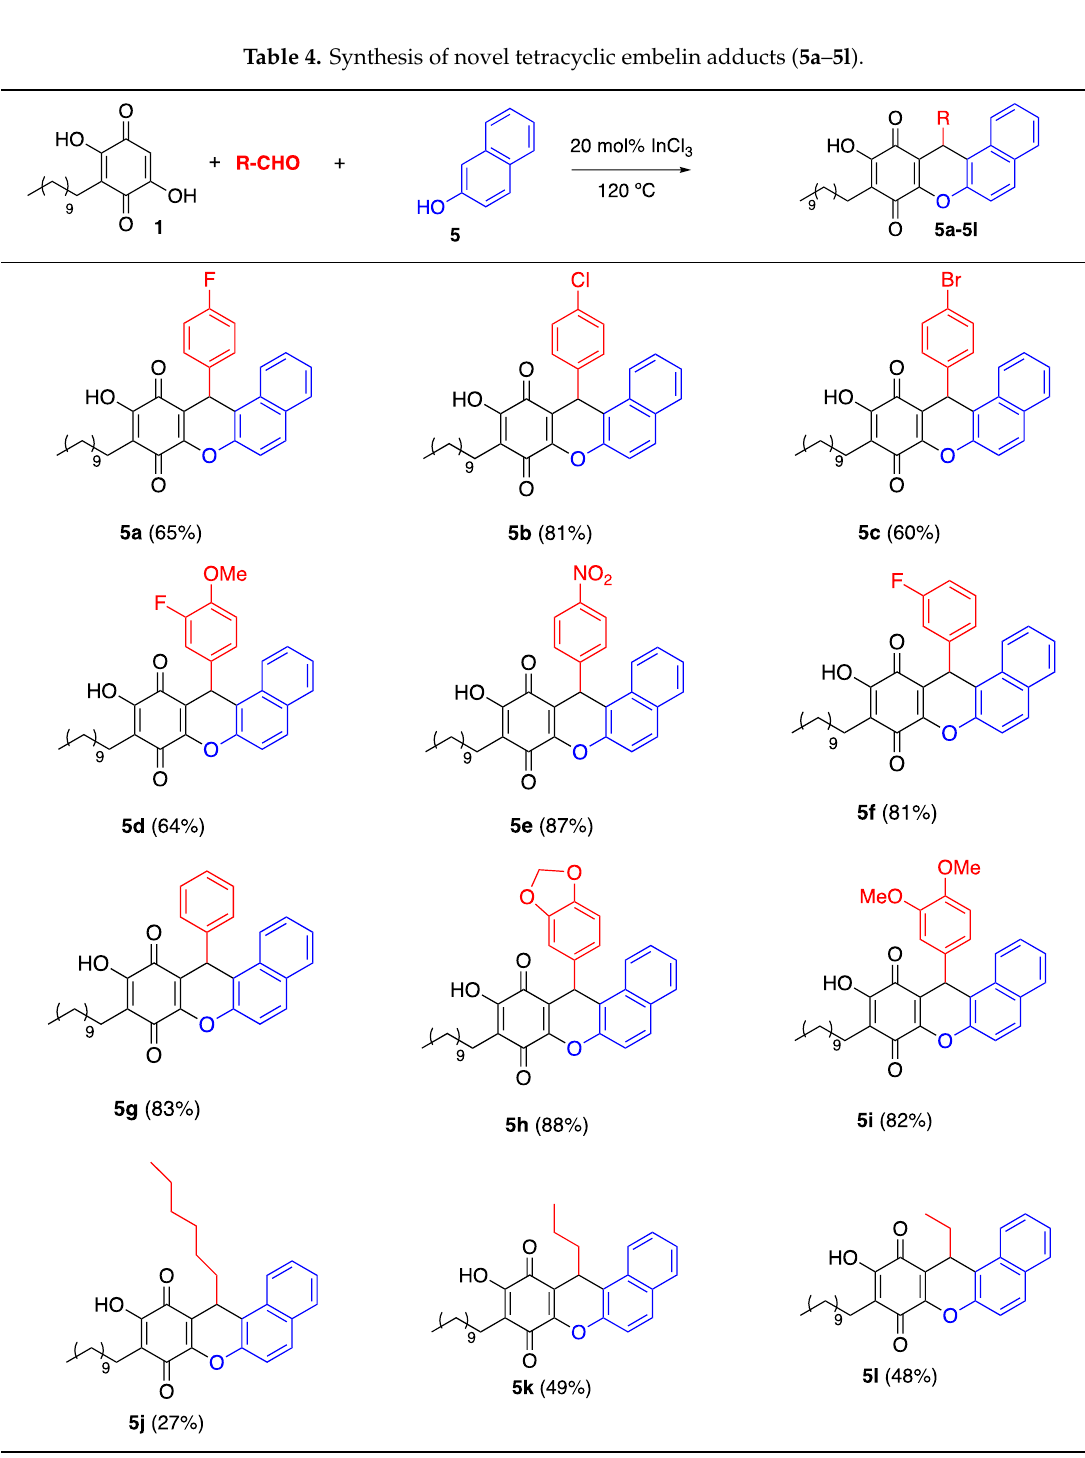
Table 5. Minimum inhibitory concentration (MIC) for compounds 1 , 3a – l , 4a – l , and 5a – l against the three selected Gram-positive bacterial strains. Entry